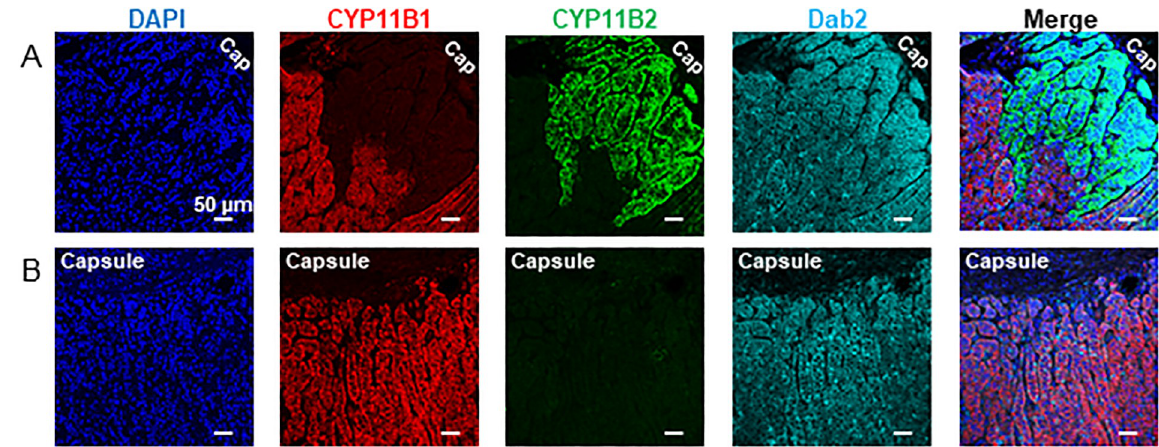
Fig 6. Dab2 expression is not restricted to the functional ZG. Triple immunofluorescence for CYP11B1, CYP11B2 and Dab2. Dab2 expression is observed throughout the adrenal cortex independently of the donor age and steroidogenic cell type. (A) 42-year-old man, Cap: Capsule. (B) 81-year-old man.